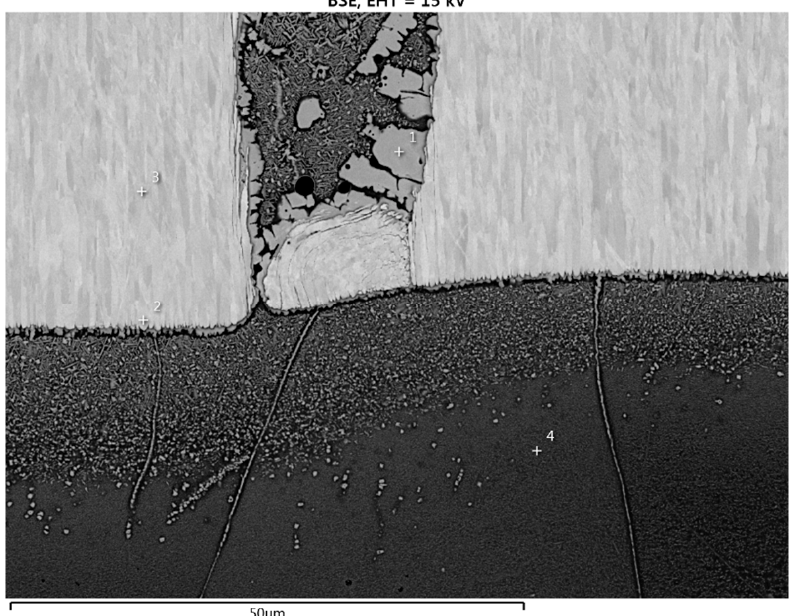
Table 2. Local composition (labeled in Figure 7) determined by EDX in at%.